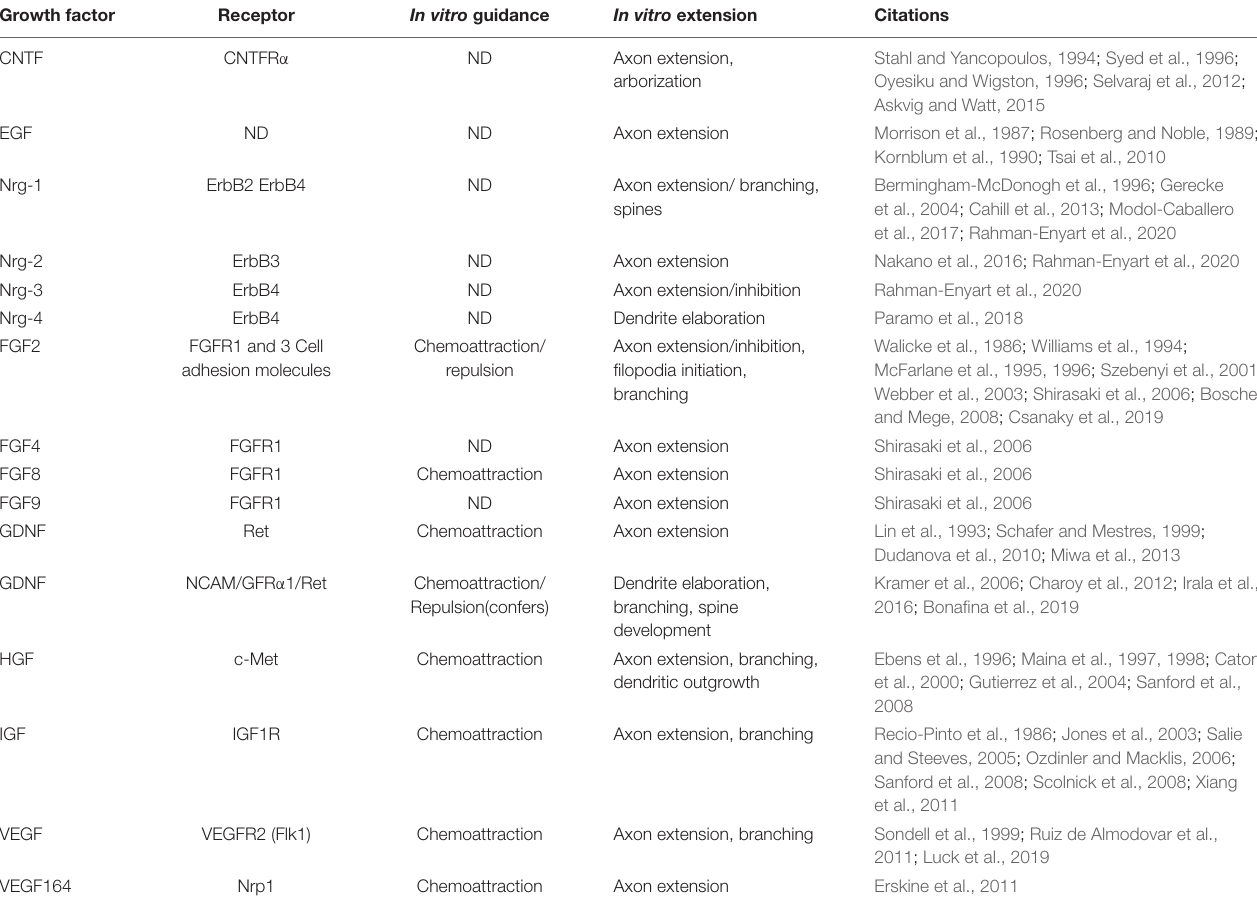
TABLE 1 | Growth factors have a wide variety of effects on the morphogenesis of developing